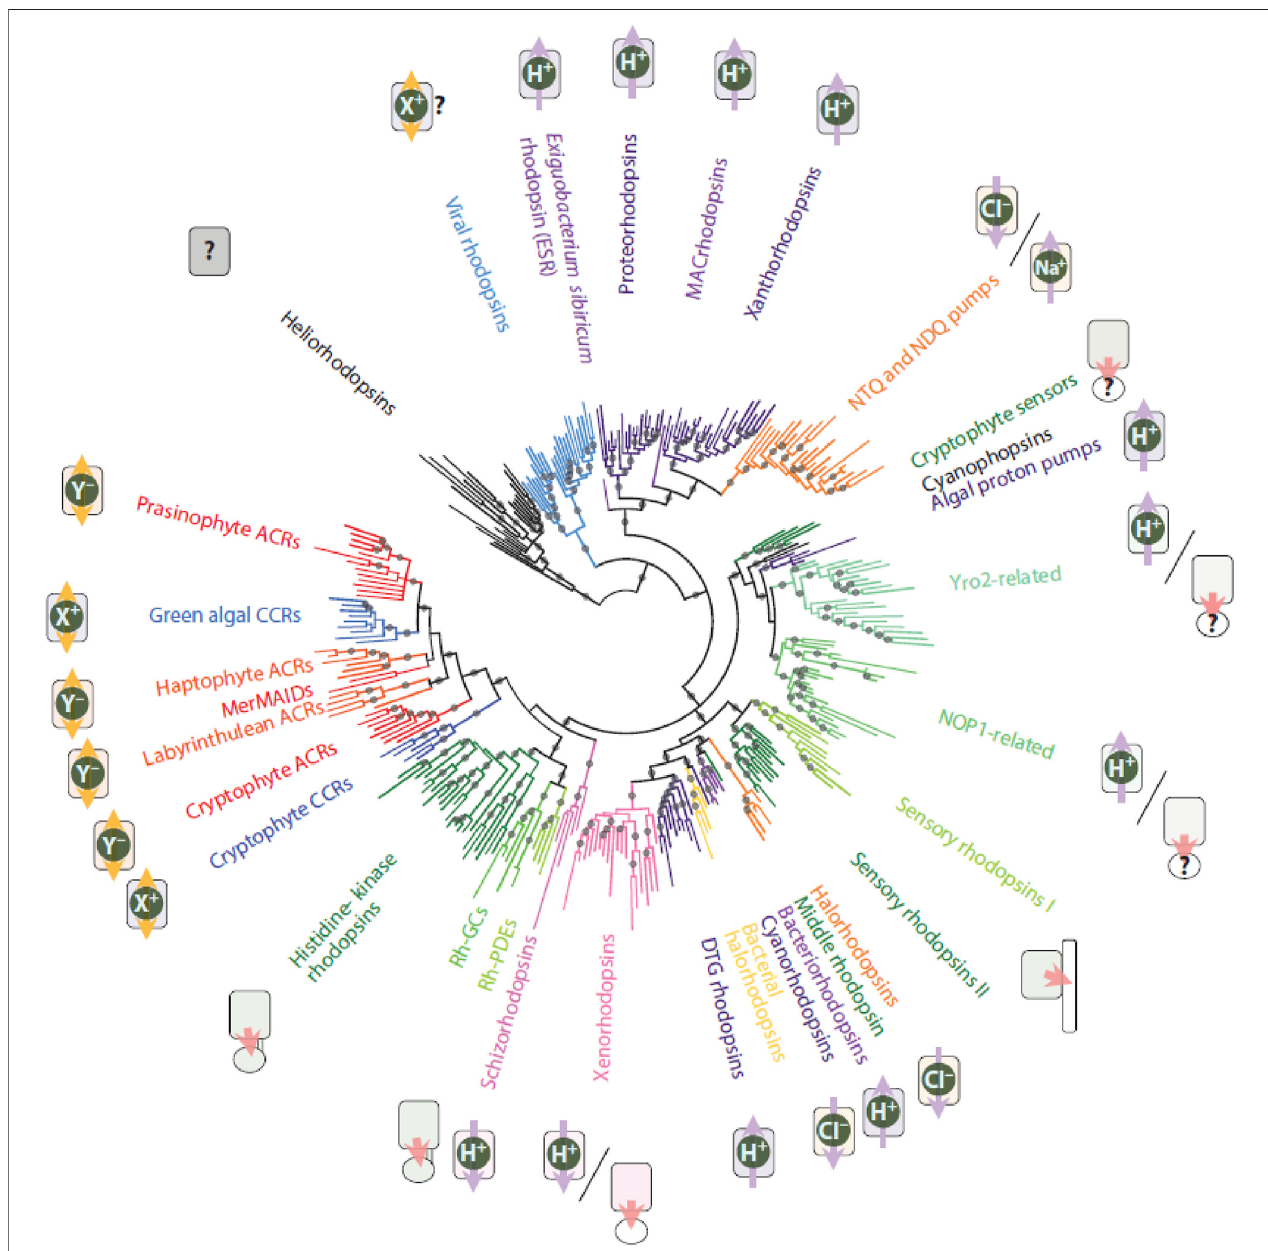
FIGURE7| Globalphylogeny oftype-1 pigments illustratingtheirformidablediversi fi cation. The fi gure wasmodi fi edwith consentfrom Rozenberget al., 2021. We refer to the original paper for the construction of the tree and for all abbreviations. Purple arrows represent active outward (away from center) and inward ion transport, respectively. Orange arrows represent ion channels. Pink arrows represent enzyme-rhodopsins (fused enzyme domains) and sensory rhodopsins (detachable transducers). For further details of the various classes we refer to recent literature (Hasemi et al., 2016; Govorunova et al., 2016; id-, 2022; Nakajima et al., 2018; Oppermann et al., 2019; Kovalev et al., 2020a; Rozenberg et al., 2021).